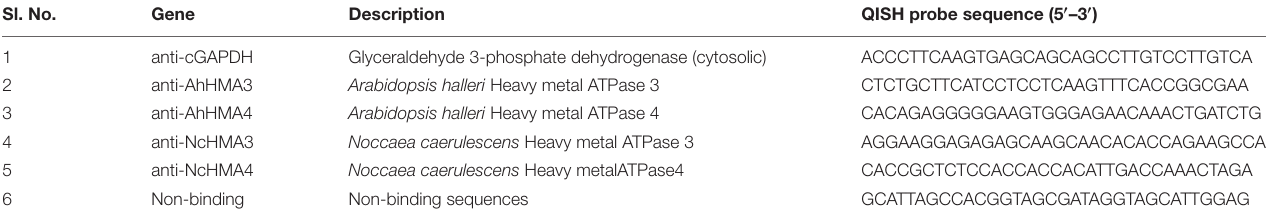
TABLE 2 | Probes used in QISH in the present study. Sl. No.